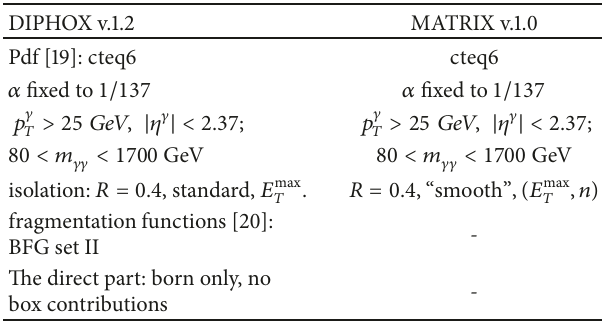
Table 1: Setup of the diphoton production process used in the NLO runs.